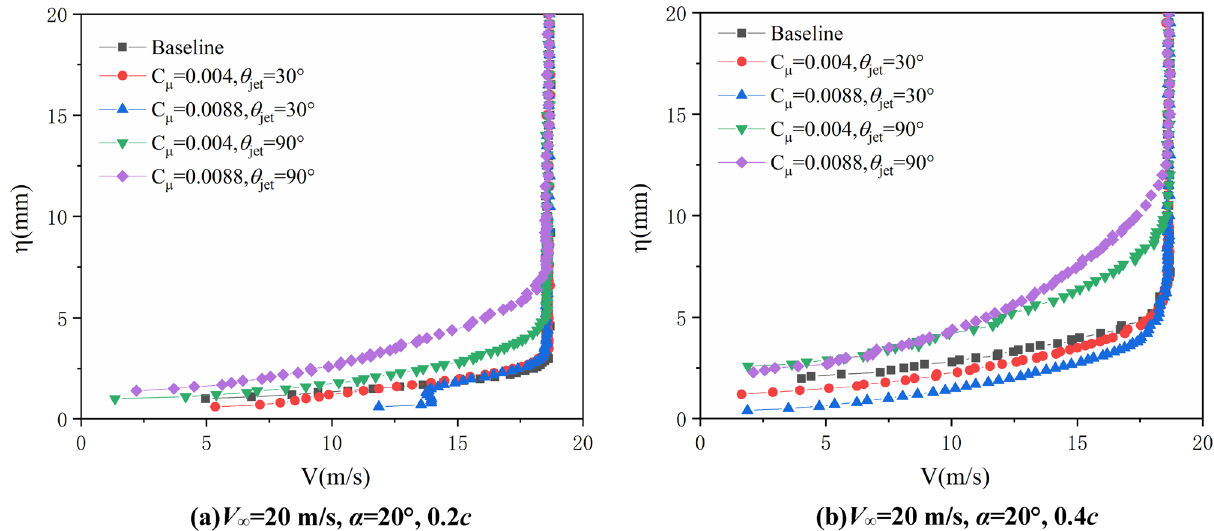
Figure 10. Test results of the boundary layer velocity profiles ( V ∞ = 20 m/s, α = 20°).